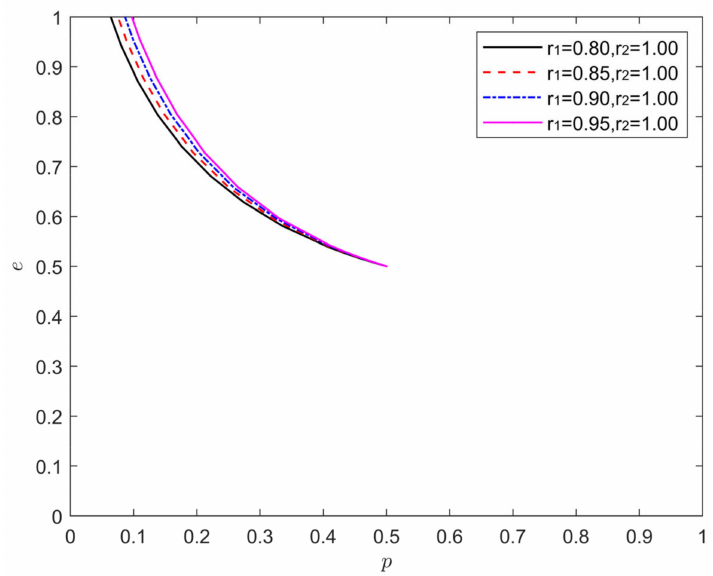
Figure 6. The development of the game’s strategy in a (optimistic, rational)